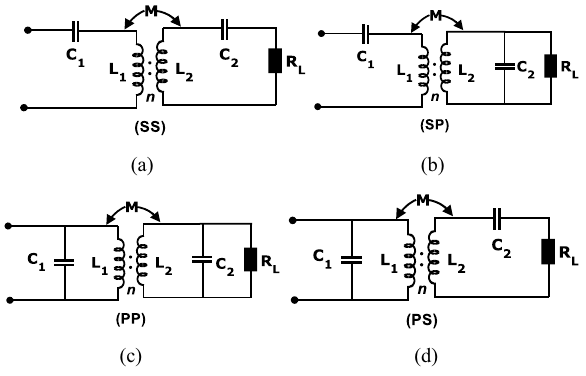
Figure 2: Comparison of near - fi eld coupling topologies: ( a ) series – series ( SS ) , ( b ) series – parallel ( SP ) , ( c ) parallel – parallel ( PP ) , and ( d ) parallel – series ( PS )